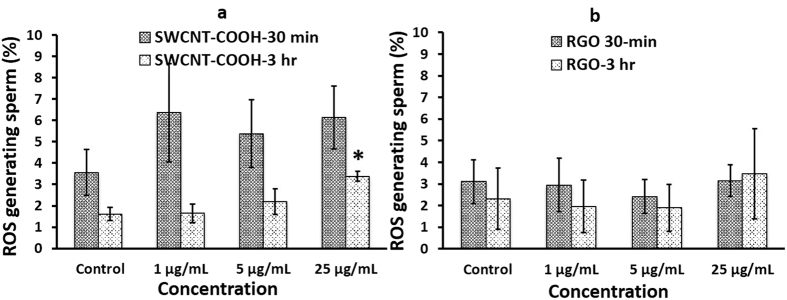
Superoxide generation at various SWCNT-COOH/RGO concentration and exposure time.Sperm population generating reactive oxide stress (ROS) for sperm samples incubated with (a) SWCNT-COOH and (b) RGO at NP concentrations of 1, 5, and 25 μg/mL for two incubation periods of 30 minutes and 3 hours. *p value < 0.05 between sample treated with SWCNT-COOH and control, N = 3. Error bars represent a standard error of the mean.